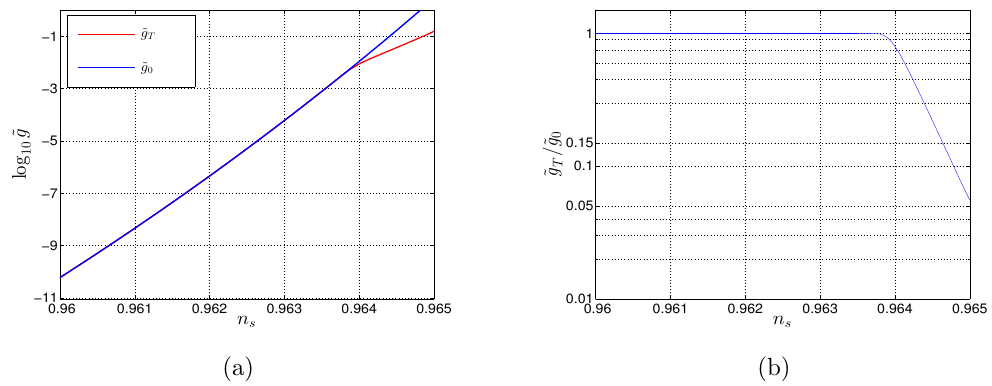
Figure 4. The spectral index dependence of the dimensionless coupling constant ~ g = g=m (cid:30) in (cid:11) -attractor E-model with g(cid:30)(cid:31) 2 interaction for (cid:11) = 1 and n = 1. In the left plot, ~ g 0 (blue line) and ~ g T (red line) correspond to eqs. (3.5) and (3.9), respectively. The right plot is to